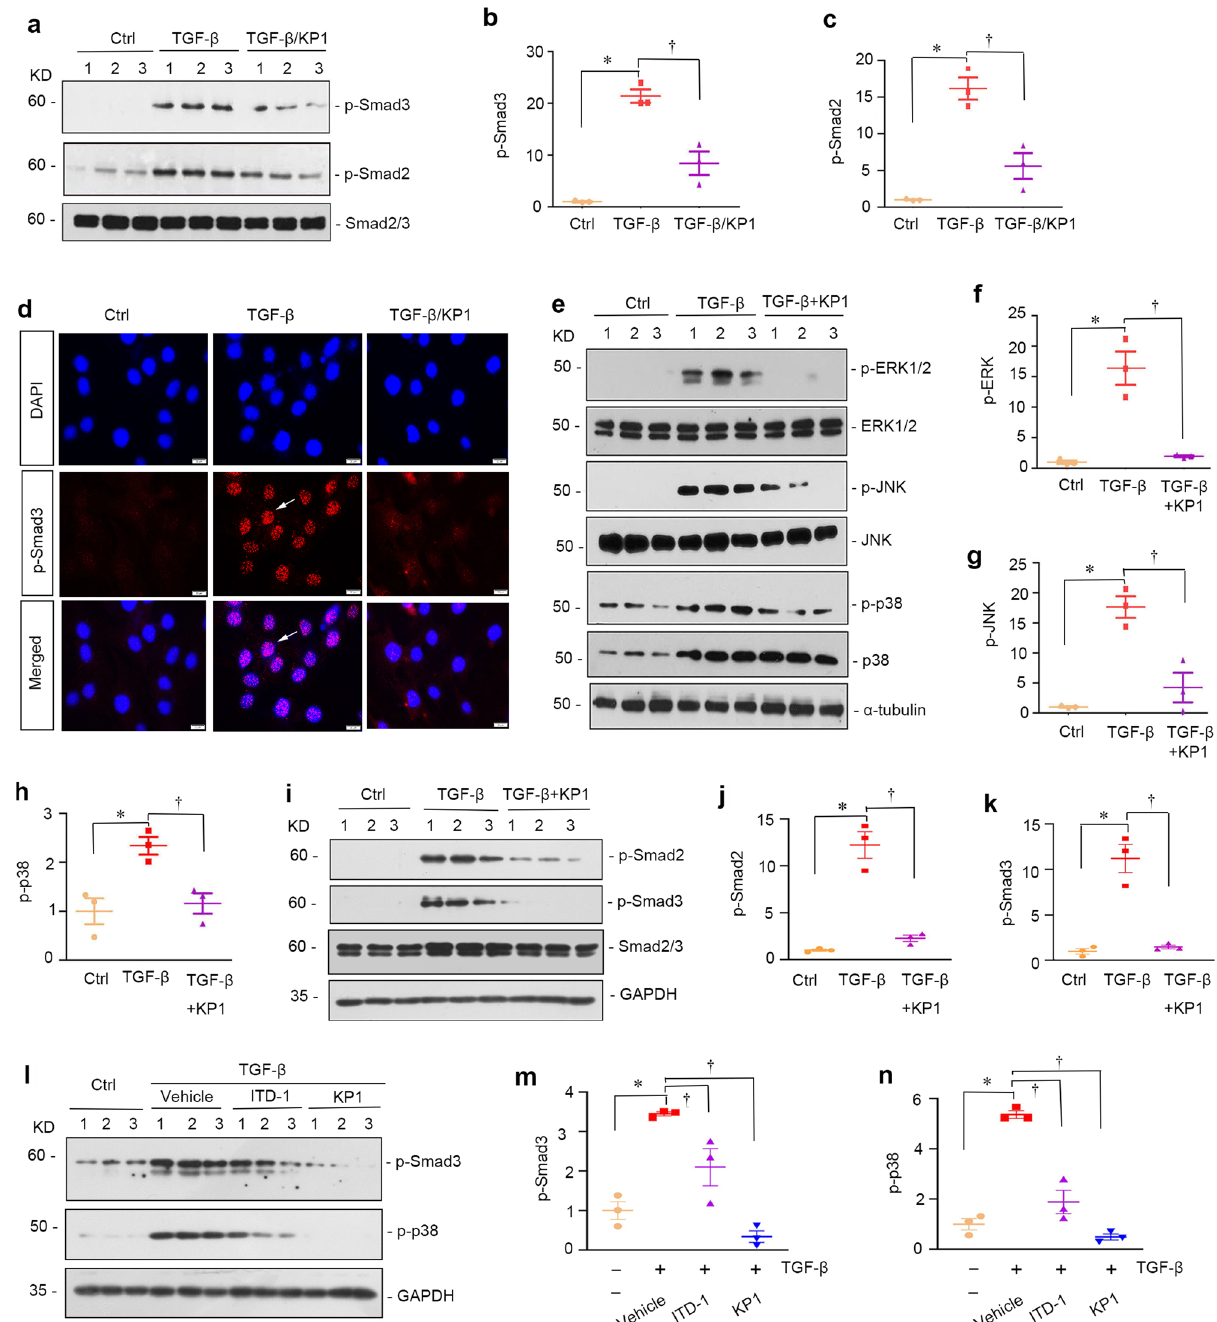
Fig. 3 KP1 inhibits multiple signaling triggered by TGF- β 1 in vitro. a KP1 inhibited the phosphorylation of Smad2 and Smad3 induced by TGF- β 1. Numbers (1 – 3) indicate each individual wells of cells. Serum-starved NRK-49F cells were pre-treated with KP1 or vehicle for 1 h and then stimulated by TGF- β 1 for 45 min. b , c Quantitative data of p-Smad3 ( b ) and p-Smad2 ( c ) in different groups are shown. P values (from left to right): <0.001 and 0.001 (p-Smad3); <0.001 and 0.001 (p-Smad2). n = 3 biologically independent cells. d Immuno fl uorescence staining of p-Smad3 showed that KP1 blocked TGF- β 1-mediated Smad3 phosphorylation and nuclear translocation. DAPI denotes the nuclei. Arrows indicate p-Smad3 positive cells. Scale bar, 20 µ m. e – h KP1 inhibited TGF- β 1-induced phosphorylation of ERK1/2, JNK, and p38. Western blot analyses ( e ) and quantitative data of p-ERK1/2 ( f ), p-JNK ( g ), and p-p38 ( h ) are shown. P values (from left to right): <0.001 and 0.001 (p-ERK1/2); 0.001 and 0.002 (p-JNK); 0.005 and 0.010 (p-p38). n = 3 biologically independent cells. i – k KP1 inhibited TGF- β /Smad signaling in primary tubular cells. Western blot analyses ( i ) and quantitative data of p-Smad2 ( j ) and p-Smad3 ( k ) in different groups are shown. P values (from left to right): 0.032 and 0.034 (p-Smad2); 0.041 and 0.049 (p-Smad3). n = 3 biologically independent cells ( l – n ) KP1 was more effective in inhibiting TGF- β signaling compared to T β R2 inhibitor ITD-1. NRK-49F cells were pre-incubated with KP1 (10 µ g/ml, 3 μ M) or ITD-1 (3 μ M) for 1 h, and then treated with TGF- β 1 (2 ng/ml) for 45 min. Western blot analyses ( l ) and quantitative data of p-Smad3 ( m ) and p-p38 ( n ) are shown. P values (from left to right): < 0.001, 0.008 and <0.001 (p-Smad3); <0.001, <0.001 and <0.001 (p-p38). n = 3 biologically independent cells. Ctrl controls. Data are presented as mean values± SEM. P values were calculated by one-way ANOVA with Fisher ’ s LSD post hoc test ( b , c , f , g , h , m , n ) or Dunnett ’ s T3 test ( j , k ). Source data are provided as a Source Data fi le.